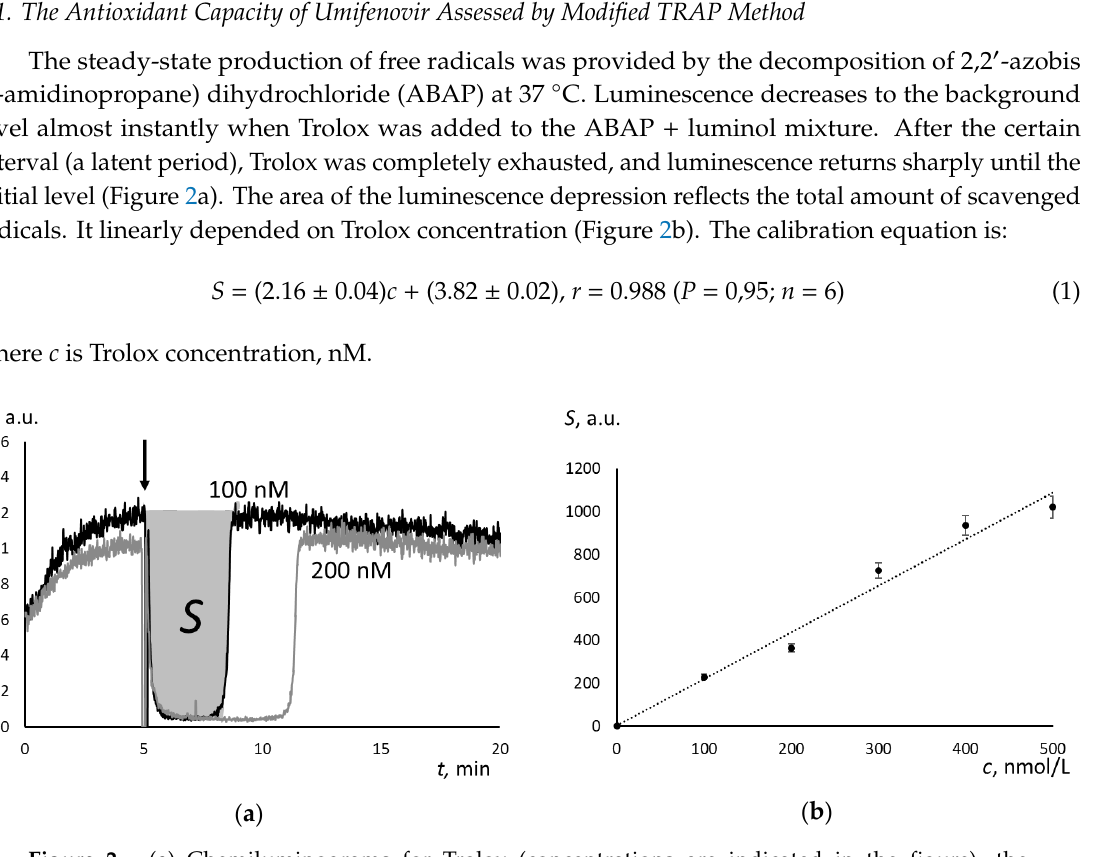
Figure 1. The structures of ( a ) Umifenovir and ( b ) Trolox.